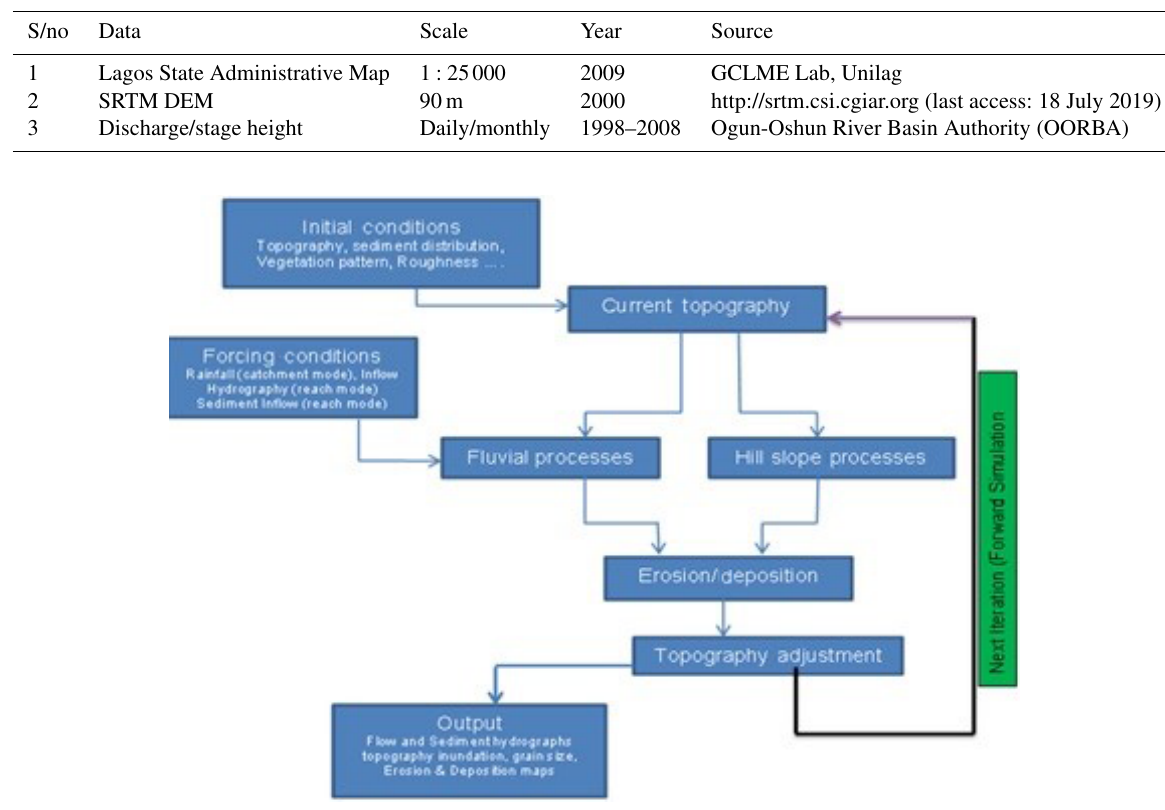
Table 1. Data source and characteristics.